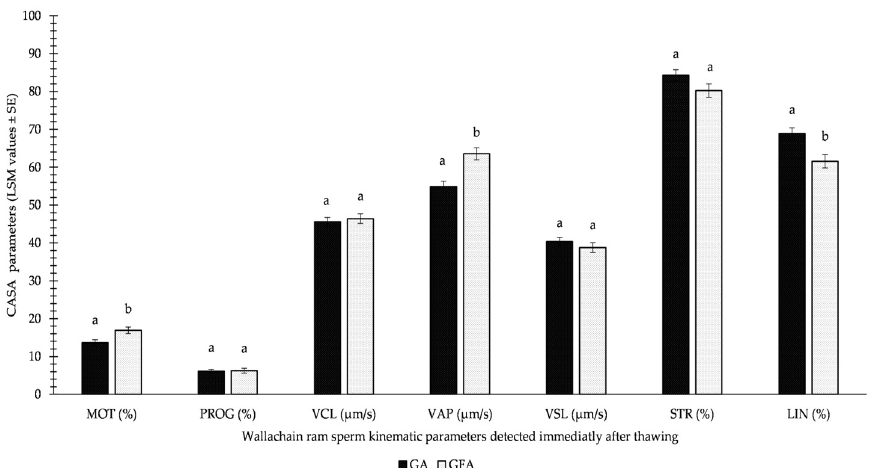
Figure 3. Influence of GA (glycerolation during the whole equilibration process) vs. GFA (glycerola- tion 10 min before the freezing procedure) on CASA parameters in Wallachian ram sperm detected immediately after thawing; MOT: total motility; PROG: progressive motility; VCL: curvilinear ve- locity; VAP: average path velocity; VSL: straight-line velocity; STR: straightness; LIN: linearity; a–b: different letters within particular parameters indicate significant differences at a p < 0.05 level of